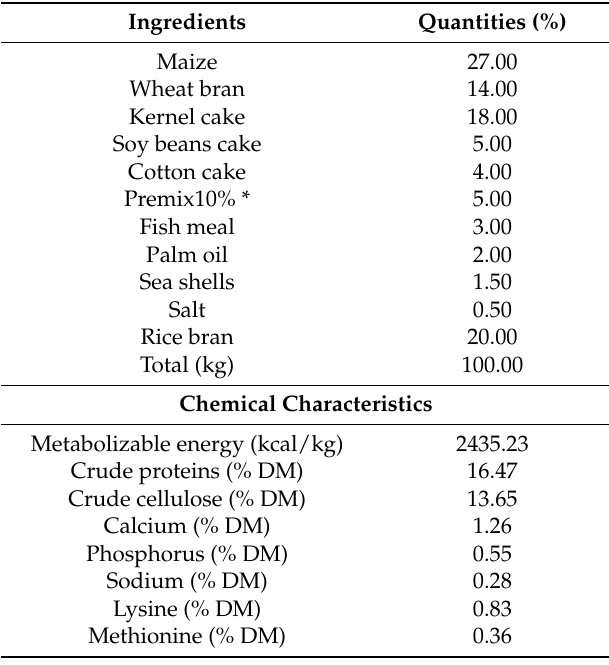
Table 1. Composition and chemical characteristics of the feed.